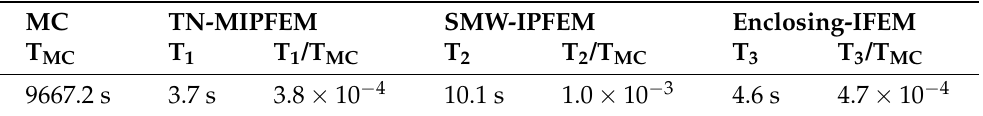
Table 1. The total calculation time by 10,000 MC, TN-MIPFEM, SMW-IPFEM, and enclosing-IFEM for 2D interior-car vibro-acoustic coupling